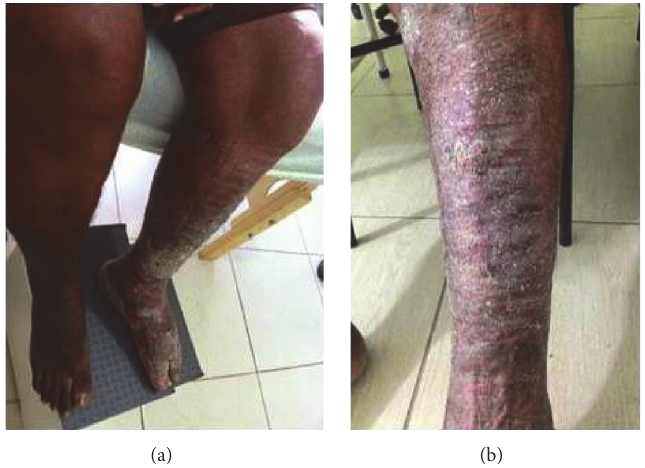
Figure 4: Evolution of the skin with functional recovery of the limb and disappearance of the plaque with treatment.